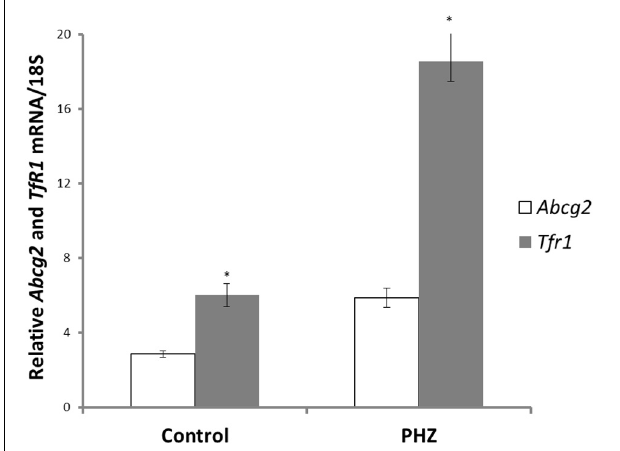
FIGURE 1 | Abcg2 and TfR1 mRNA levels in bone marrow precursor cells of CD1 mice. Erythropoiesis was induced with phenylhydrazine (PHZ) administration (60mg/kg) over 2 days. Relative mRNA expression was obtained by normalizing mRNA levels to 18S mRNA. Analysis by Students’ T -test showed significant effects of abcg2 ( P < 0 . 01), and TfR1 ( P < 0 . 005) over the control